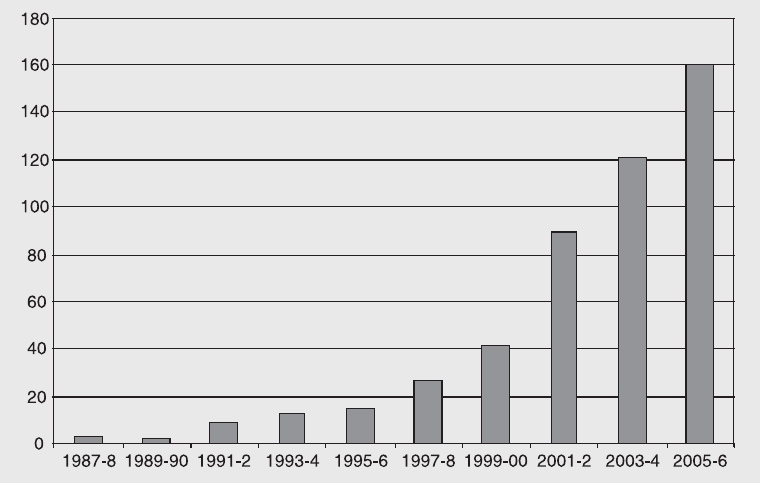
Figure 1. Number of publications referring to birth cohort studies in the last 20 years (1985- 2006). Based on a search of the PubMed database (http://www.ncbi.nlm.nih.gov/sites/ entrez?db=PubMed) for any article containing the terms “birth cohort study” or “birth-cohort study”; no language